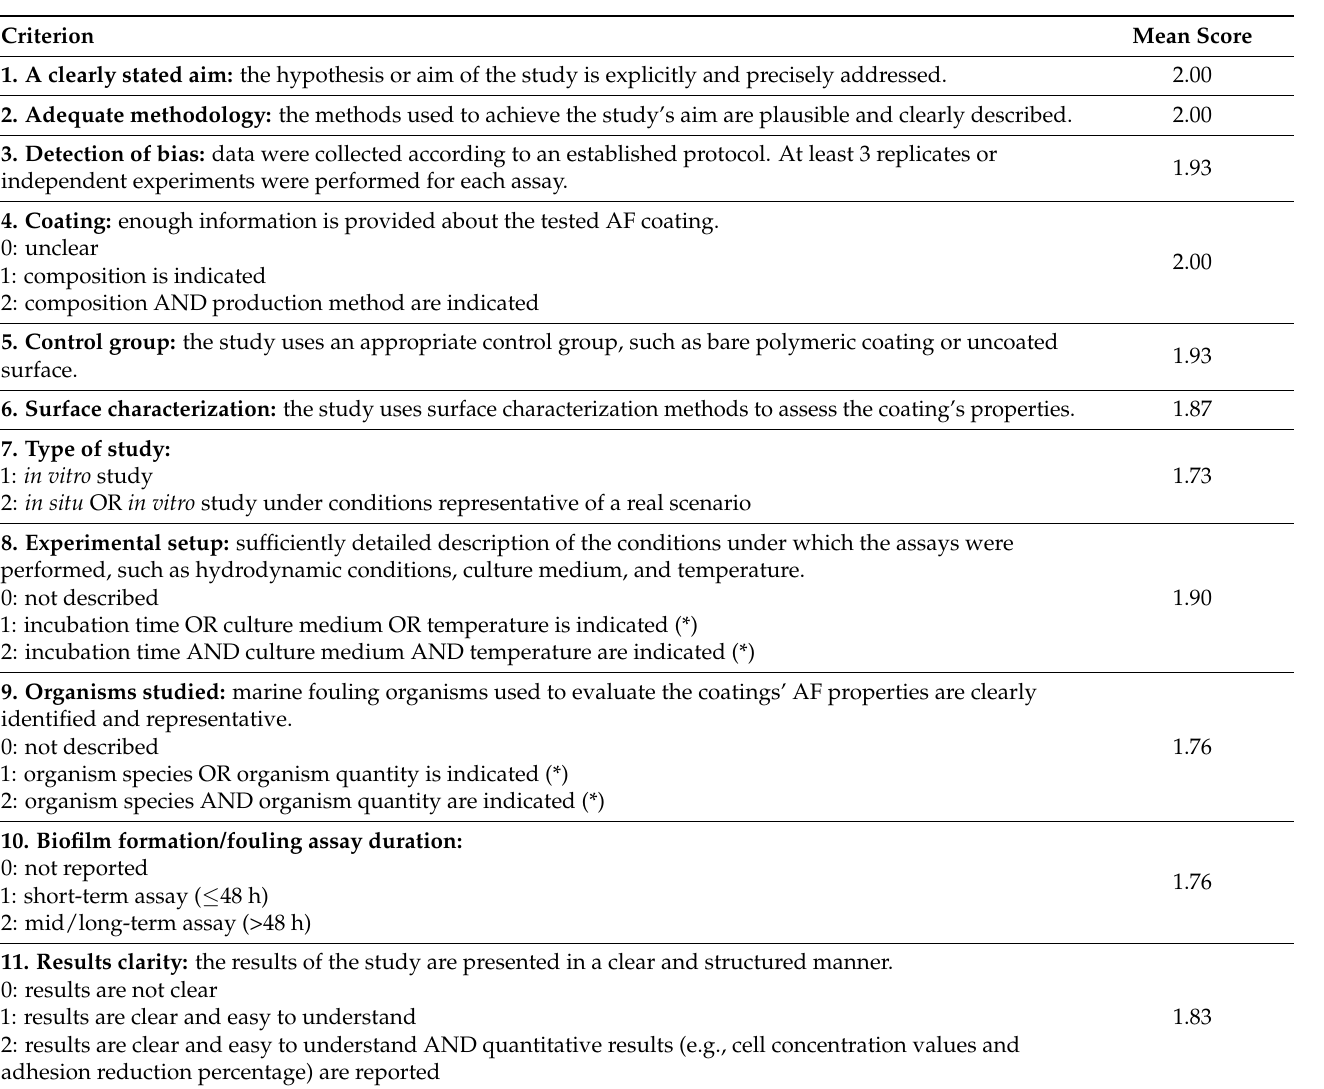
Table 3. Adapted MINORS scale and mean score of the assessed